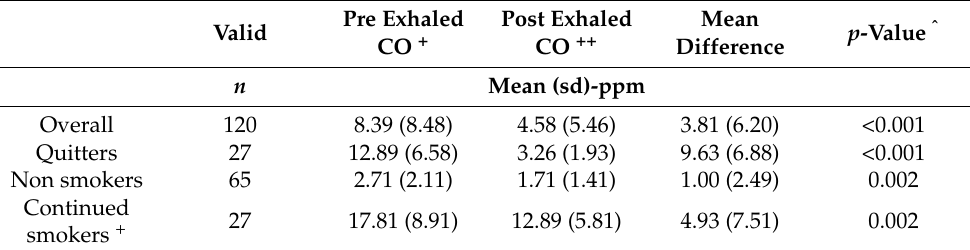
Table 4. Changes in Pre and Post Exhaled Carbon